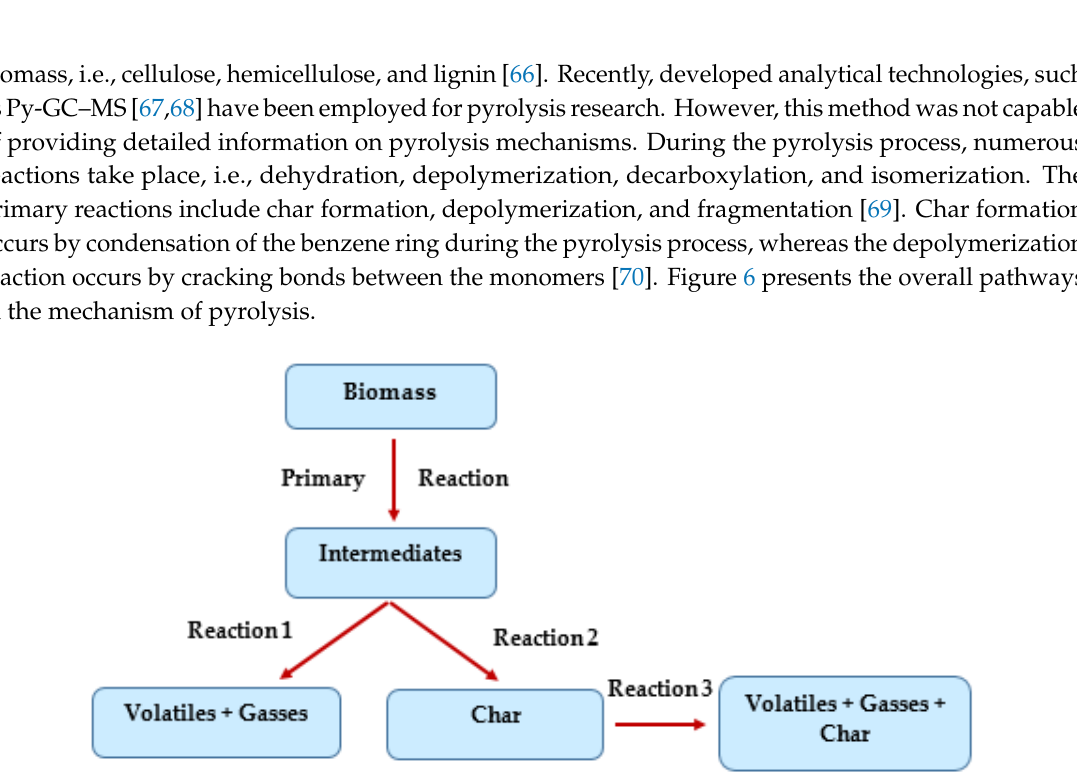
Figure 6. The overall pathways involved in the mechanism of pyrolysis (adapted from [20]).